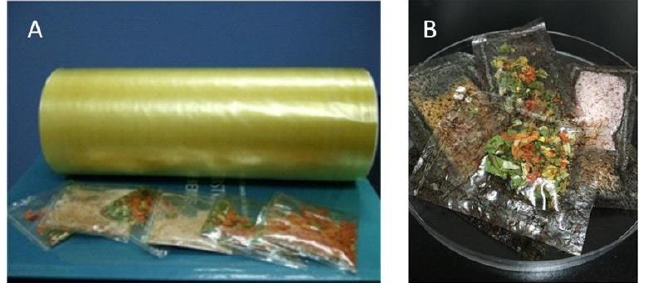
Figure 5. Photos of starch-based film and flavor bag packaging without ( A , B )